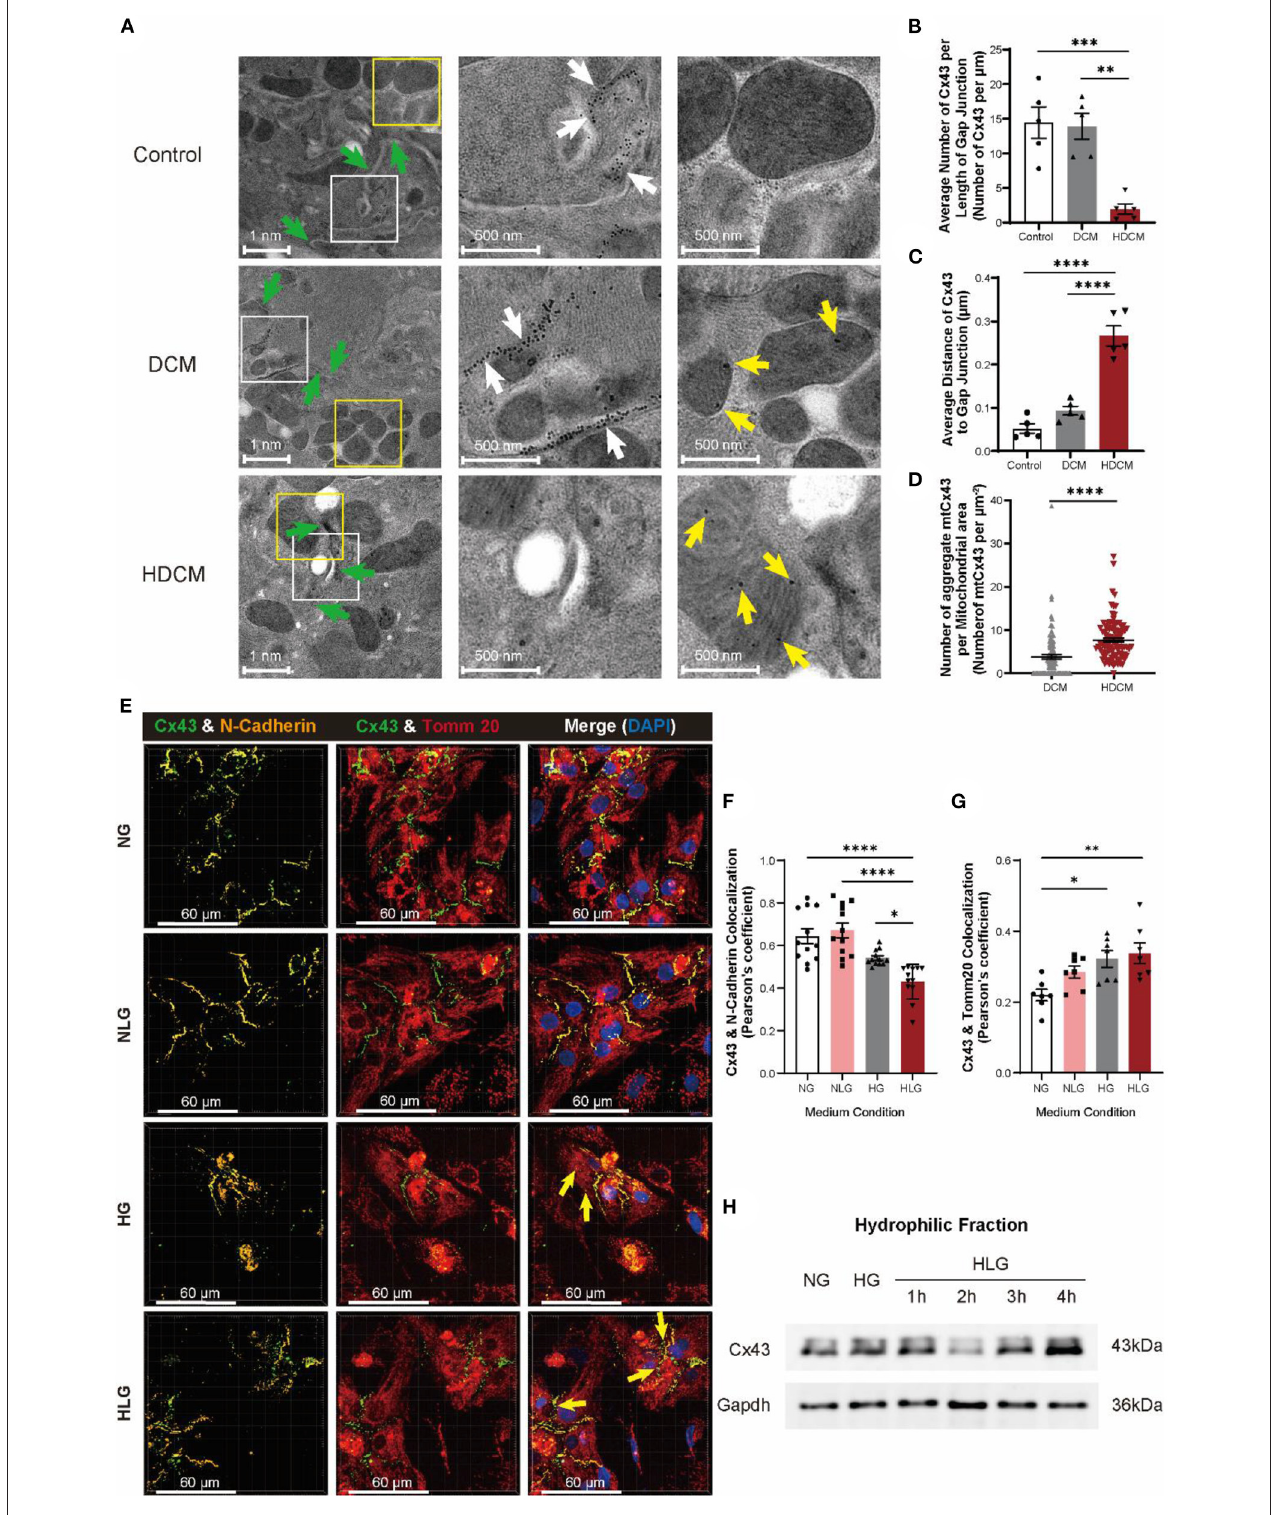
FIGURE 5 | Hypoglycemia is responsible for degradation and displacement of Cx43. (A) Immunoelectron microscopy images of Cx43 in myocardial tissue of control, DCM, and HDCM (green arrow: cell–cell interactions; scale bars, 1nm; white arrow: Cx43 at cell–cell interactions; scale bars, 500nm; yellow arrow: aberrant Cx43